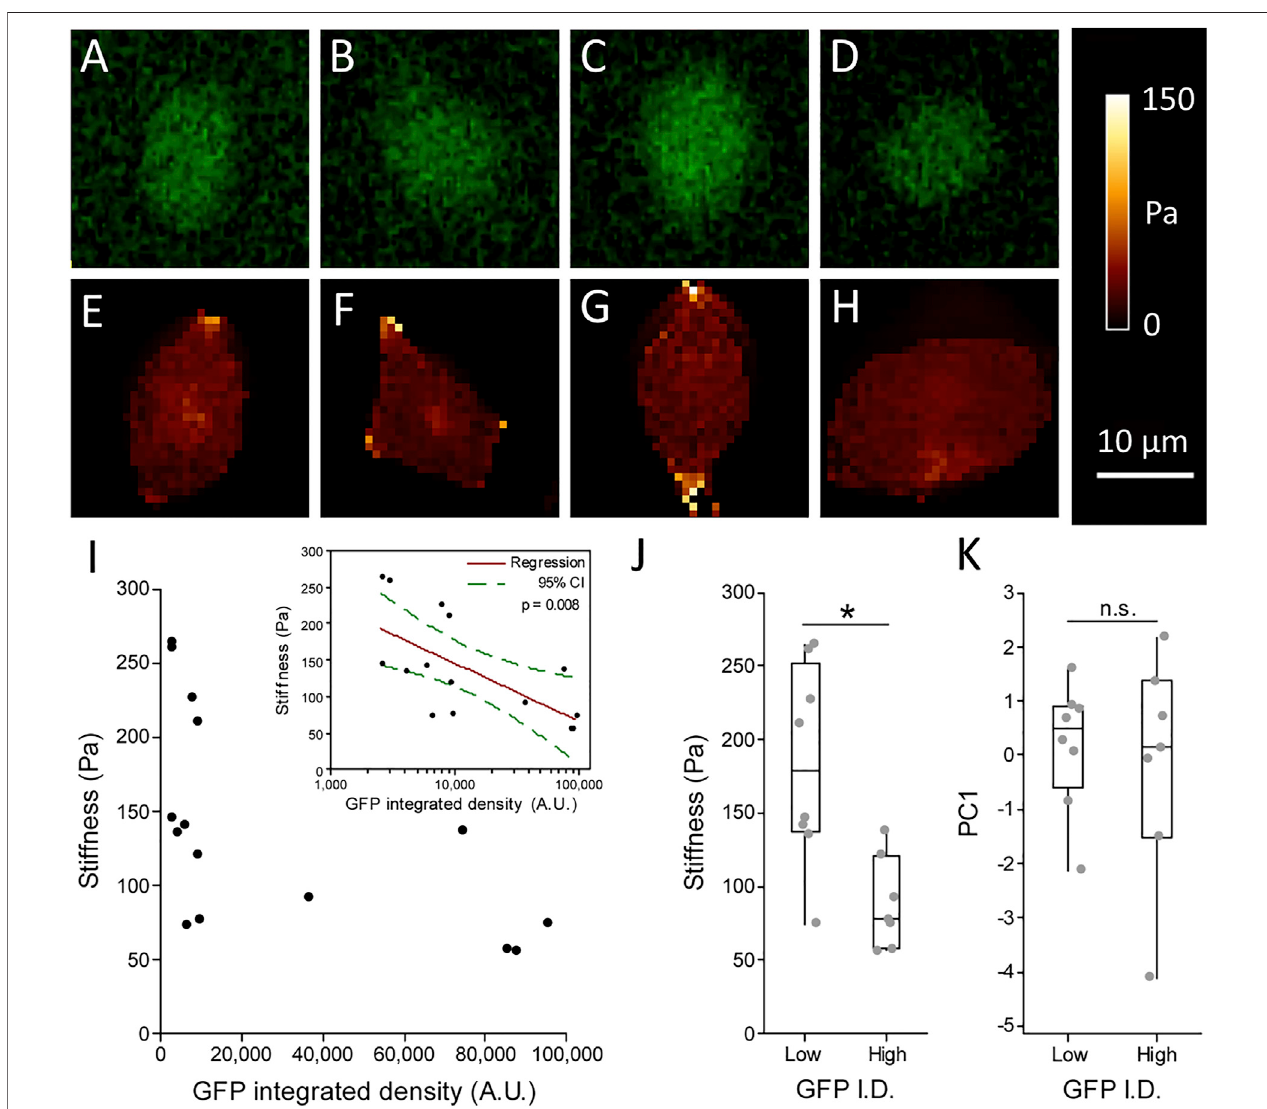
FIGURE 7 | Relationship between Stiffness and Rex1-GFP expression in individual cells. Live Rex1-GFPd2 cells cultured in LIF/FBS were seeded into glass- bottomed imagingdishes and subjected toAFM force spectroscopycombined with fl uorescencemicroscopy,sothat GFPintegrateddensity (A – D) and stiffness (E – H) could be determined on a cell-by-cell basis. Figures (E – H) are high resolution maps, while cell stiffness values presented in (I – J) are the median of multiple point measurements within individual cells (5 measurements each, n = 15 cells, Gavara and Chadwick 2015). ( I ) Stiffness plotted against GFP integrated density (I.D.) revealed all cells stiffer than median (137 Pa) have low GFP intensity, while cells above median brightness (~8.9 × 10 3 A.U.) are also soft (I , grouped data in J) . Inset: Stiffness is negatively associated with GFP expression. n = 15, Linear regression with log transformed GFP integrated density, p = 0.008. Consistent with prior results, morphologydoesnotseemtobeconnectedtoRex1-GFPexpression (K) .Boxesrepresentmedianandinterquartilerange,withwhiskersextendingto1.5×interquartile range or the max/min data points. n = 7 – 8, Mann-Whitney test, n.s. p = 0.862, * p = 0.013.